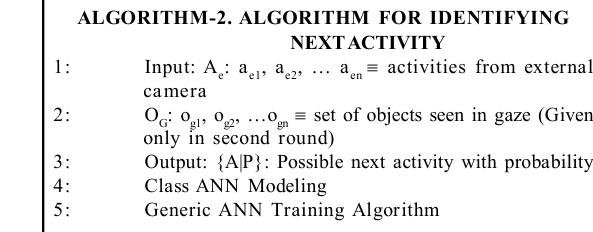
ALGORITHM-2. ALGORITHM FOR IDENTIFYING NEXT ACTIVITY